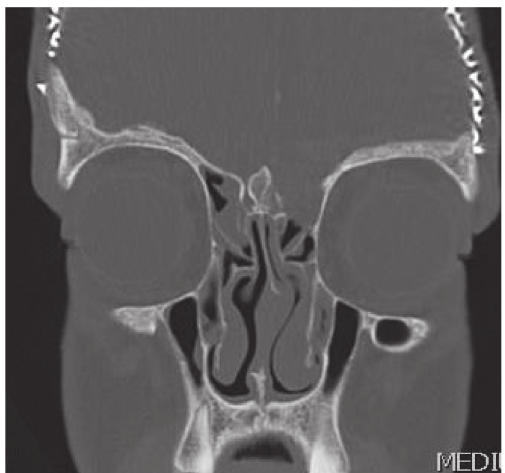
Figure 11: Computed tomography of the paranasal sinuses in the coronal plane, showing a frontal meningocele protruding through a frontal sinus defect.